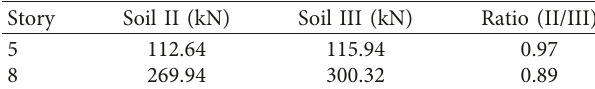
Table 8: Average of shear story under near-field